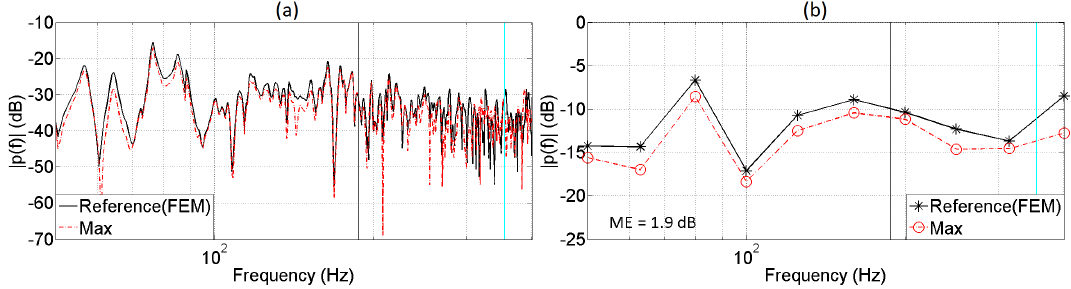
Figure 30. Comparison of full ( a ) and 1/3 octave band ( b ) frequency responses. Translated PWE ( X ) and reference ( X ) at translated Position